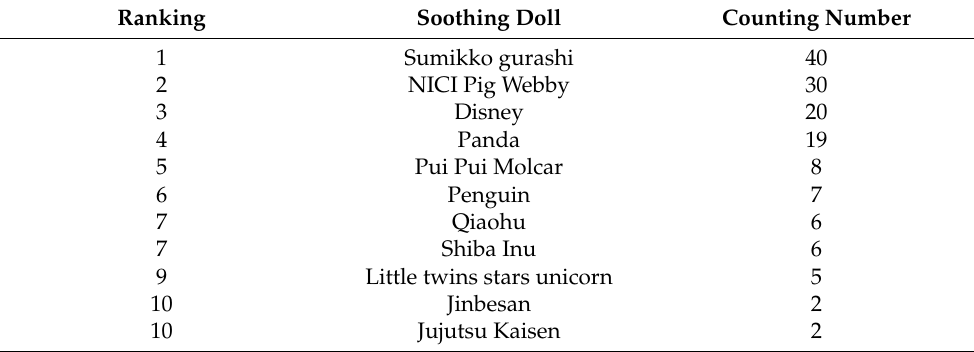
Table 1. Soothing doll sales data